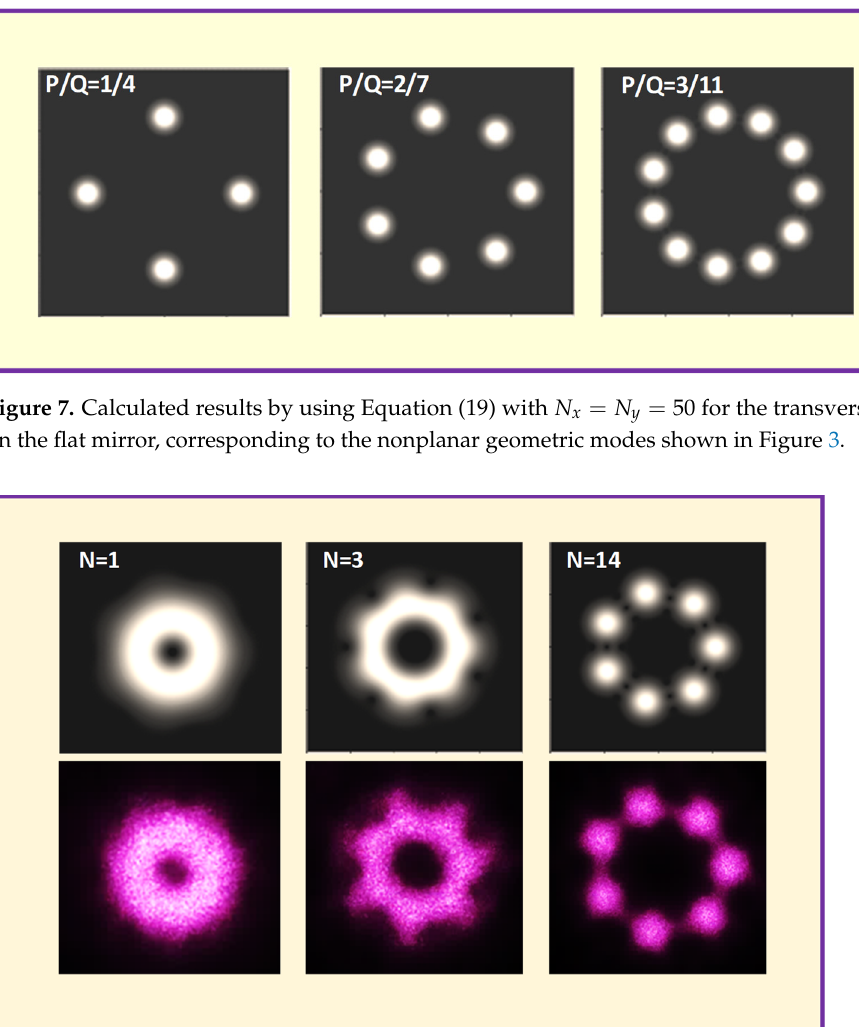
± Ψ r on the flat mirror ( ) ( r ) on the flat mirror , N N N , N